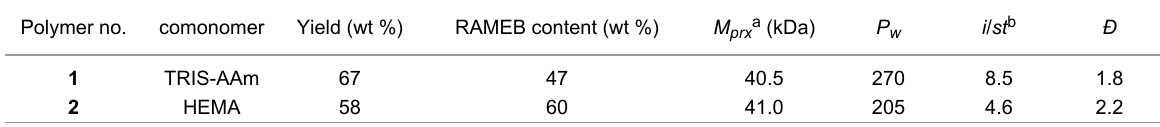
Table 1: Yields, CD contents and weight average molar masses ( M prx ), degrees of polymerization ( P w ) and isoprene/stopper ratios ( i / st ) and dispersi- ties ( Ð ) of the produced RAMEB based polyisoprene polyrotaxanes. Polymer no.